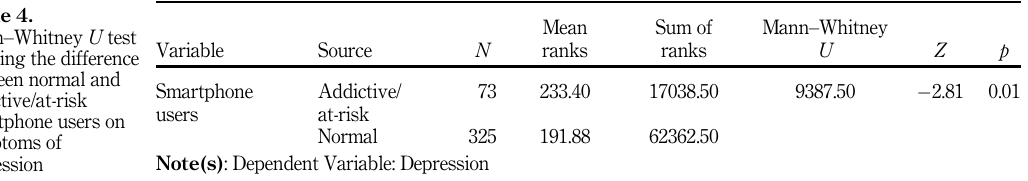
Table 5. Mann – Whitney U test showing the difference between normal and addictive/at-risk smartphone users on symptoms of anxiety